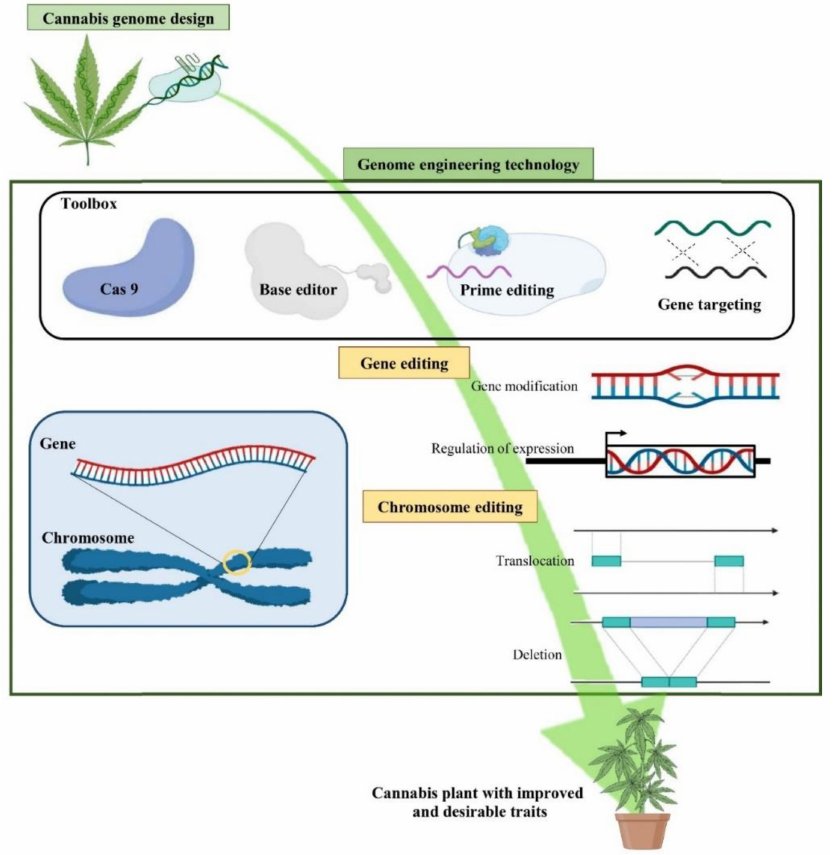
Figure 9. A schematic view of Cannabis genome